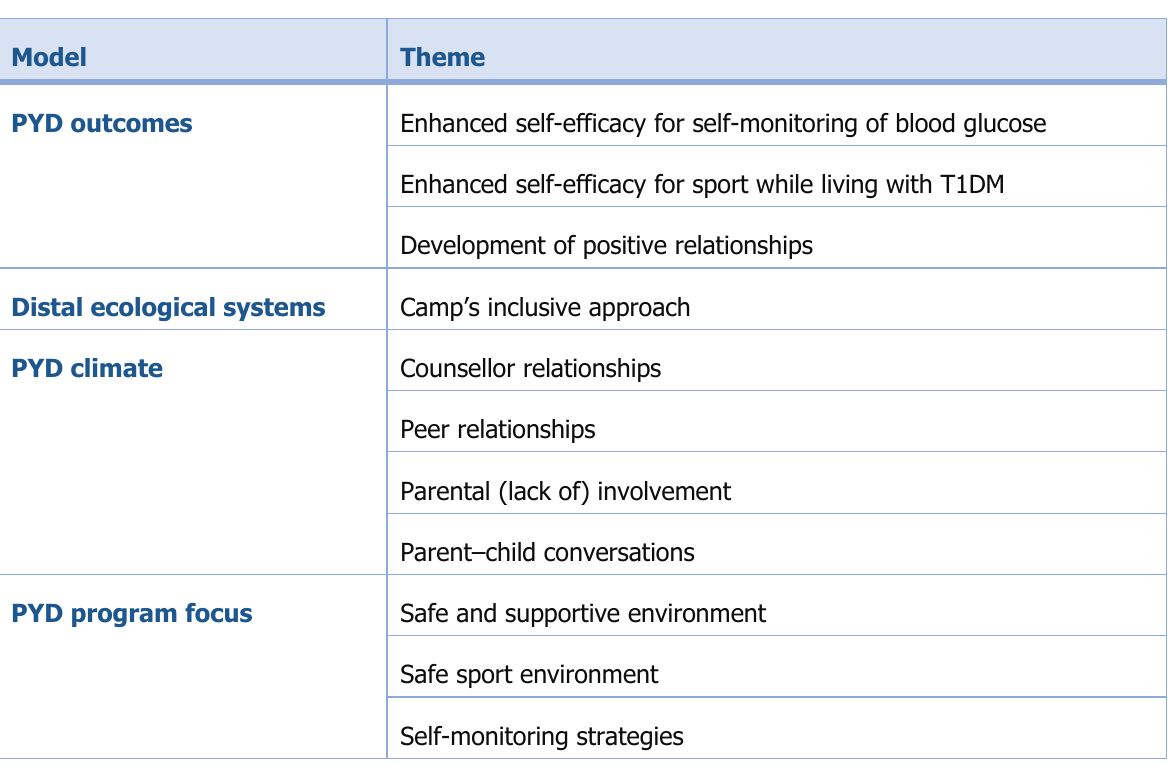
Table 1: Themes Reported in the Holt and Colleagues’ (2017) PYD Through